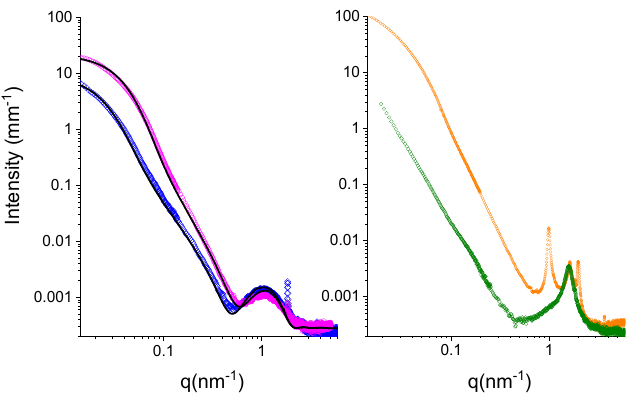
Figure 3. SAXS spectra of Tween 20 and Span 20-based niosomes. Panel A. Tween 20-based empty niosomes (blue diamonds) and Nio-AgNPs (magenta dots). Fitting curves have been obtained by modeling the particle as an internal solvent core surrounded by a surfactant closed bilayer (for details, see Supporting Information). Panel B. Span 20-based empty niosomes (green diamonds) and Nio-AgNPs (orange dots).